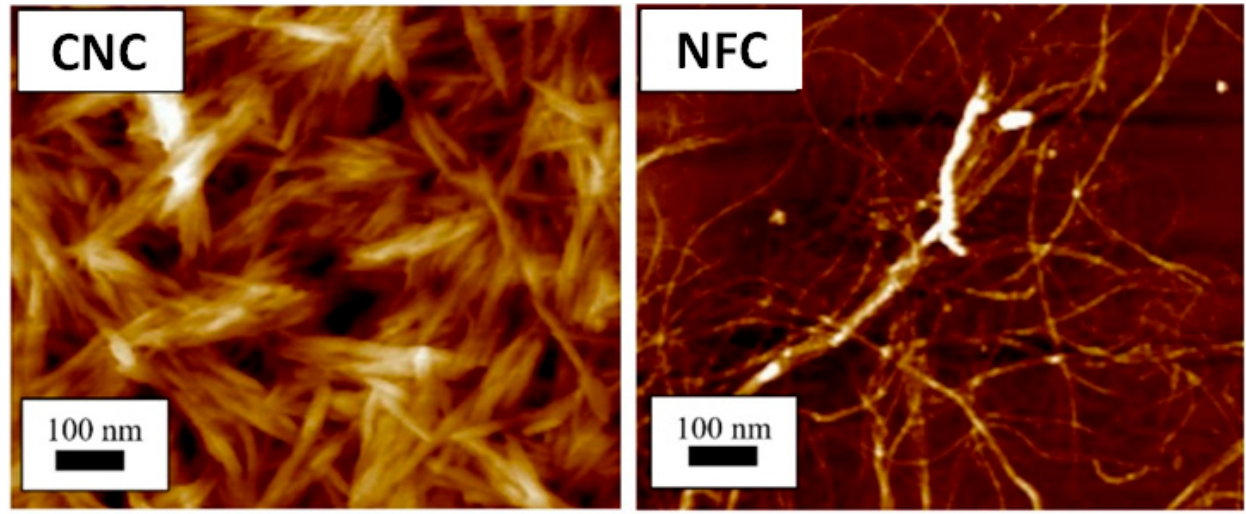
Figure 2. Atomic force microscopy images showing different structures of CNC [54] and NFC. Adapted from [55].